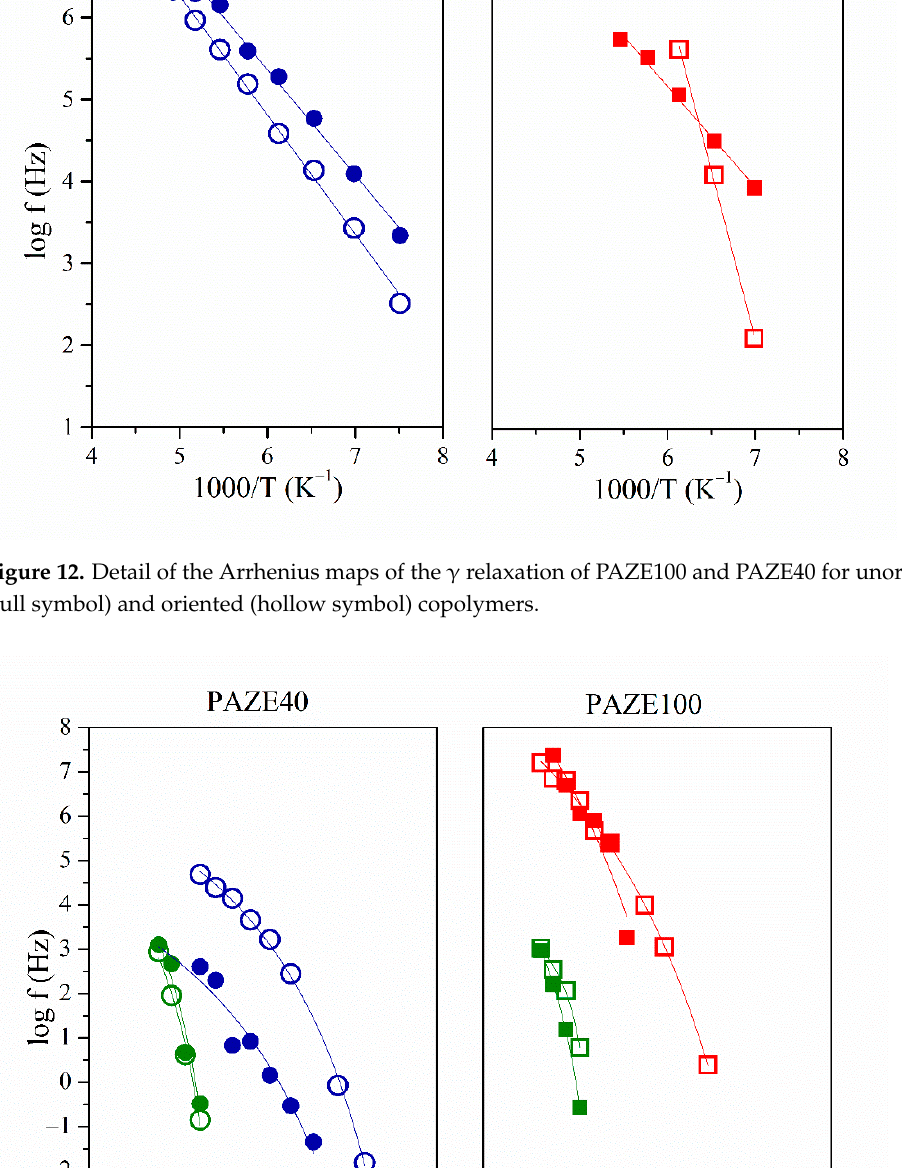
Figure 13. Detail of the Arrhenius maps of the α Tg (circles) and α Clear (triangles) relaxations of PAZE100 and PAZE40 for unoriented (hollow symbols) and oriented (full symbols) copolymers. At higher temperatures, the relaxation was ascribed to the clearing transition and labelled as α Clear